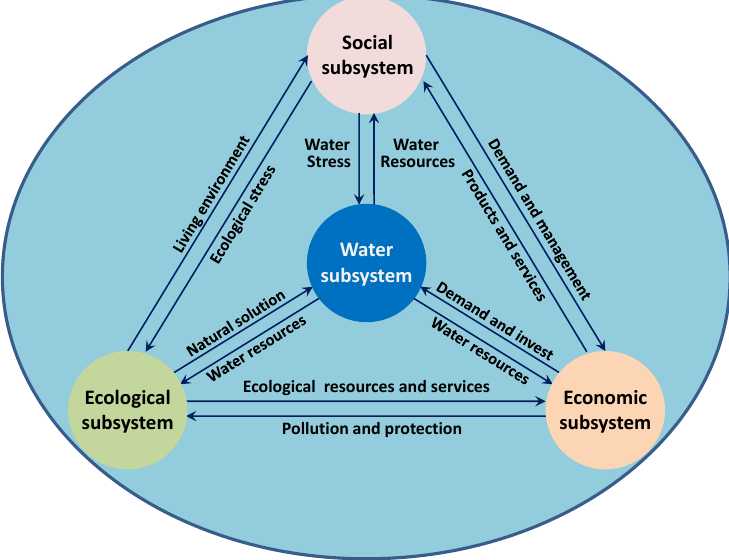
Figure 2. Relationships among subsystems in a sustainable water resource system (SWRS) (revised from Du et al., 2015 [34]).